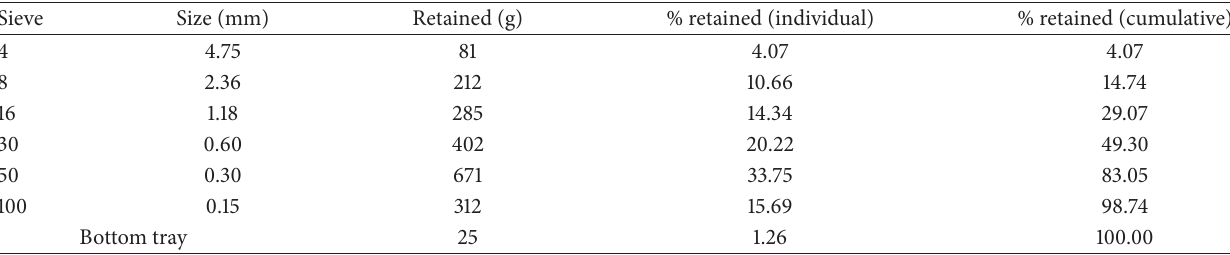
Table 2: Sieve analysis of sand (fineness modulus = 3.7).